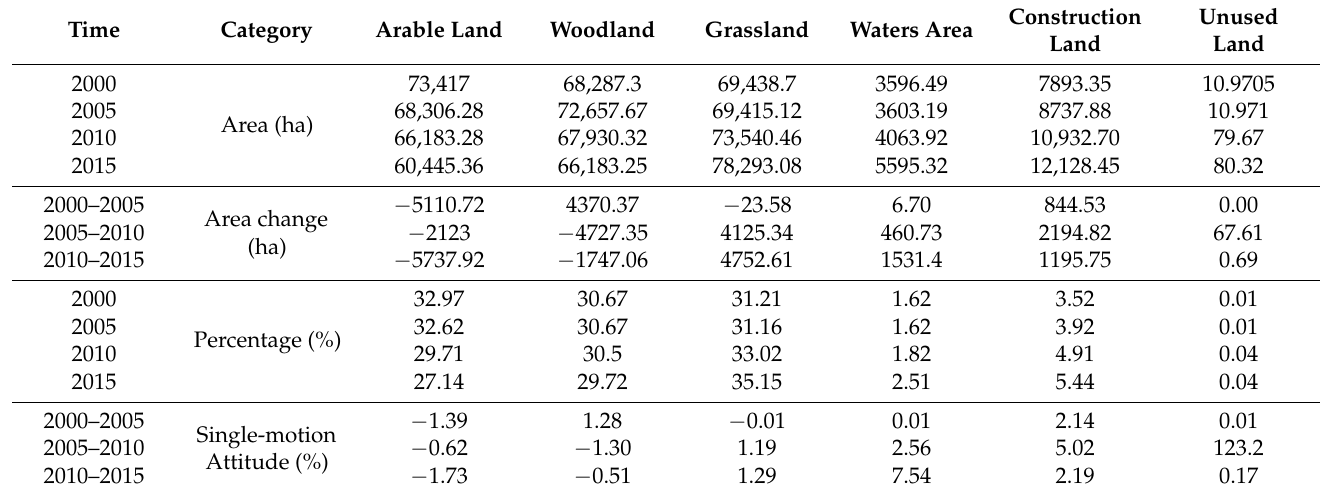
Table 2. Land-use/cover change (ha) and percentage (%) in Qihe watershed from 2000 to 2005.